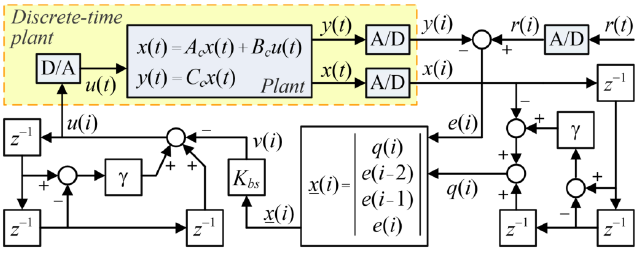
Figure 1. Structure of the proposed controller. The terms A c , B c and C c define the continuous-time state-space plant